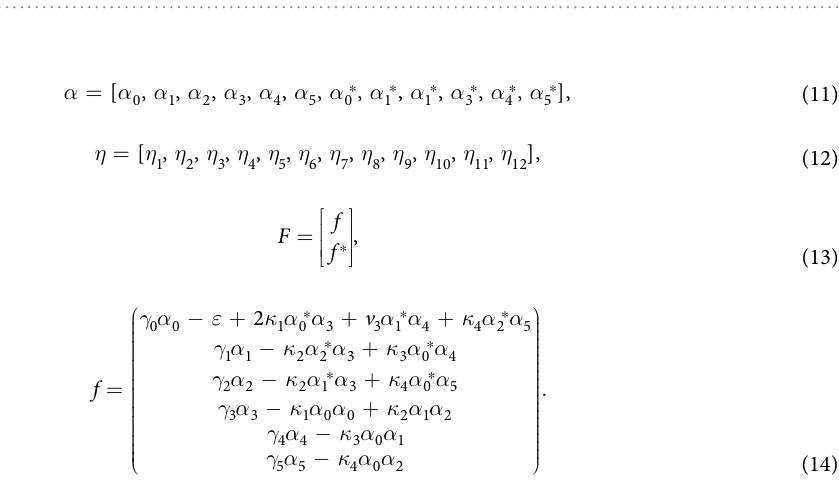
Figure 4. Four variances versus frequency of pump plots when γ c / γ is 0.05, 0.3, 0.7, 1. The pump power is fixed at 1.5 ε th